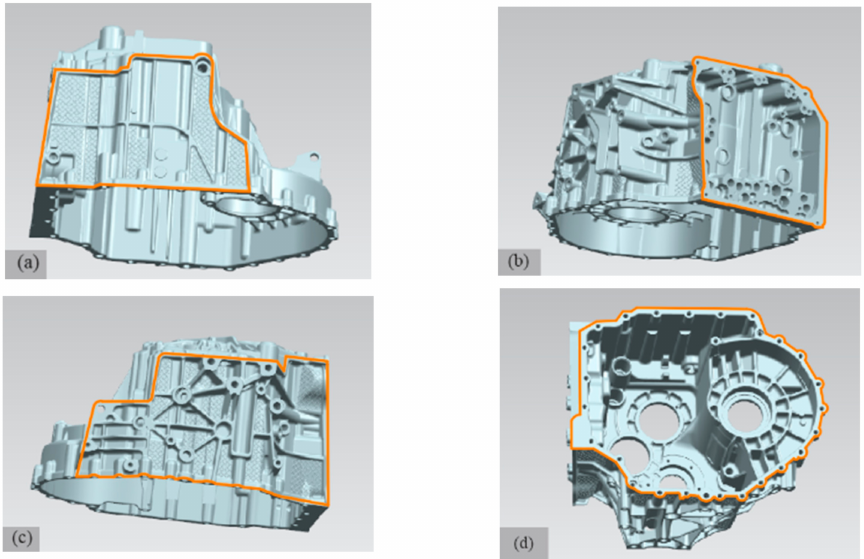
Figure 3. Casting parting diagram: ( a ) parting line of slide block; ( b ) parting line of side slider; ( c ) parting line of the upper slider; ( d ) parting line of moving and fixed